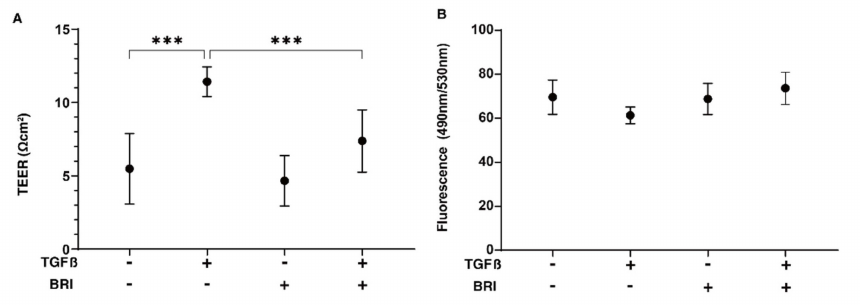
Figure 1. Effects of brimonidine (BRI) on the TEER and FITC dextran permeability of TGF- β 2-treated 2D monolayers of HTM cells. The effects of brimonidine (BRI, 10 µ M) on the barrier function ( Ω cm 2 ) of TGF- β 2 (TGF β , 5 ng/mL)-untreated (NT) or -treated 2D HTM cells were studied by TEER measurements ( A ) and FITC dextran permeability ( B ). “+” is reagents addition. “ − ” is reagents non-addition. Experiments were conducted in triplicate using freshly prepared samples ( n = 4). Regarding the data, the mean ± standard error of the mean (SEM) are presented. *** p < 0.005; ANOVA followed by a Tukey’s multiple comparison